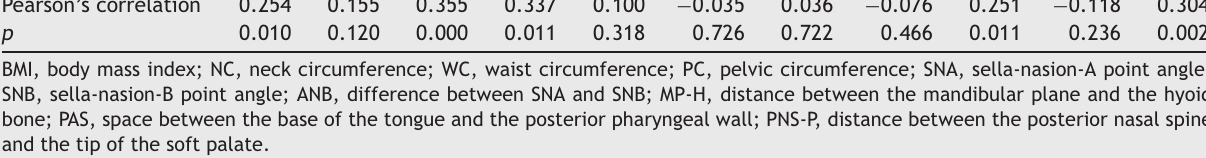
Correlation of age and anthropometric and cephalometric measurements with the AHI in the full sample ( n = 102). Age BMI NC WC